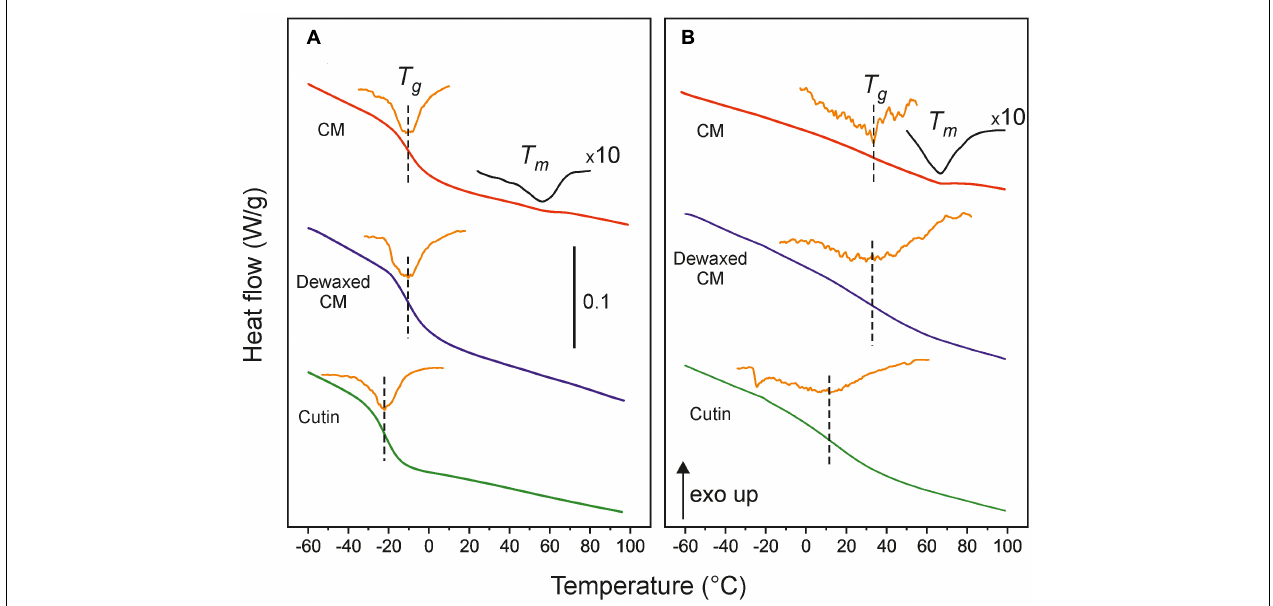
FIGURE 3 | DSC thermograms of isolated and dewaxed cuticle membranes and cutins of (A) immature green (20 daa) and (B) red ripe (55 daa) tomato fruits. The orange line is the derivative of the heat flow signal and marks the T g value. For CMs, an expanded heat flow trace ( × 10) is included to facilitate the visualization of the wax melting peaks. The bar in (A) represents a 0.1 W/g heat flow